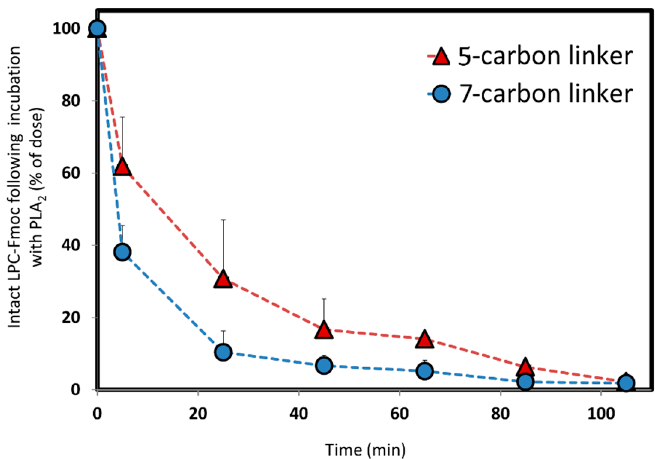
Figure 4. The degree of intact LPC-Fmoc conjugate (with -5 and -7 carbon unit linker) following a 105 min incubation with PLA 2 (% of dose). Data are presented as average ± SD; n = 3.